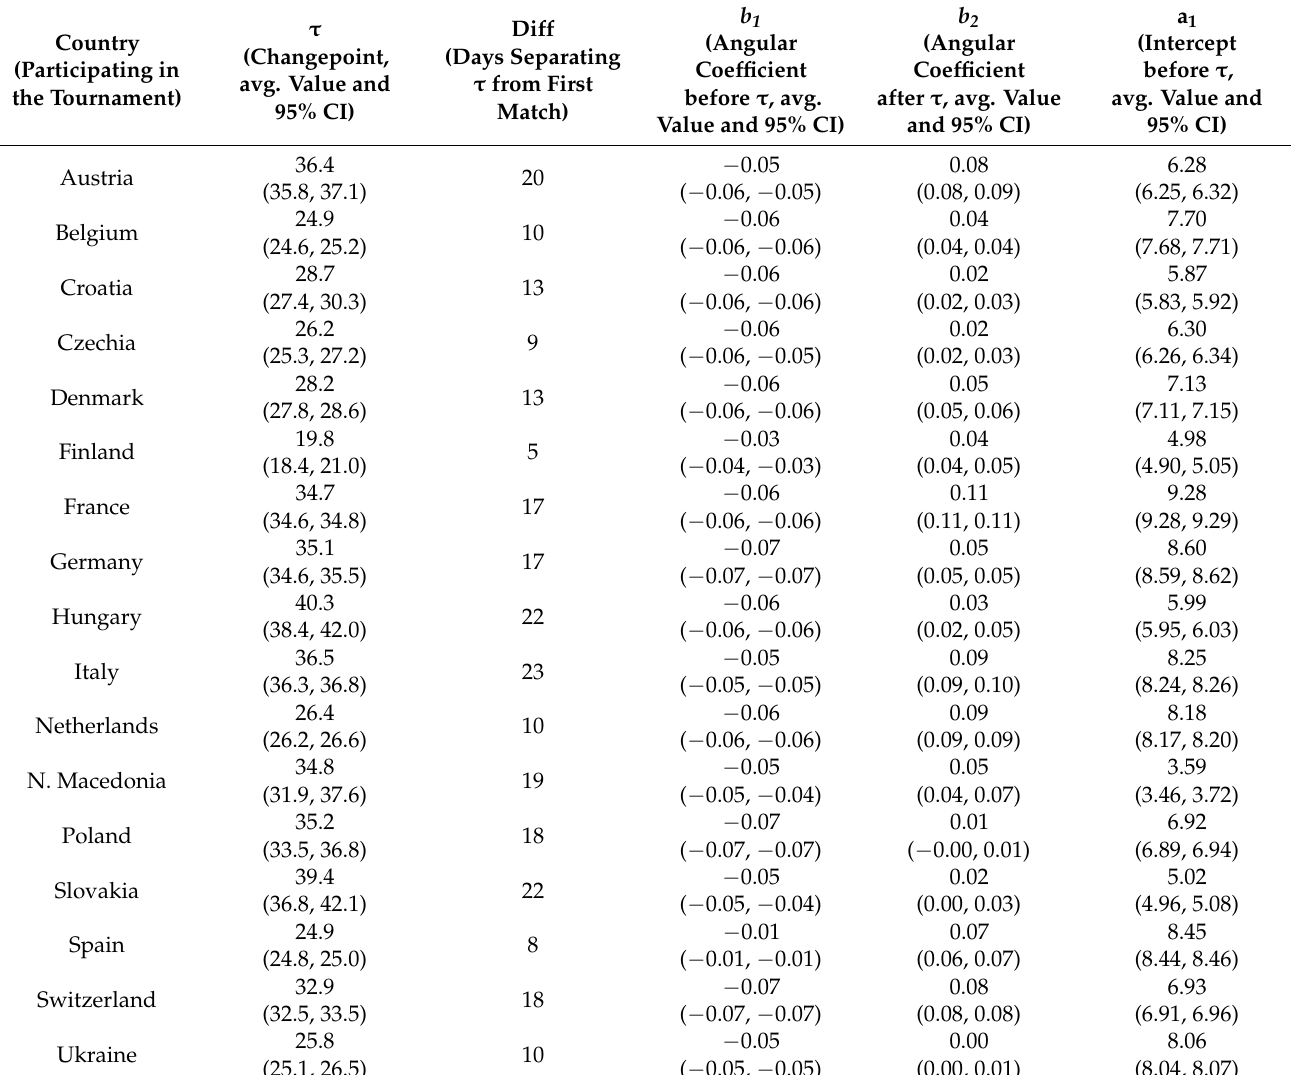
Table 1. Countries with a changepoint coincidental with a reversal from a decrease to an increase in the SARS-COV-2 case rate that occurred during the European football